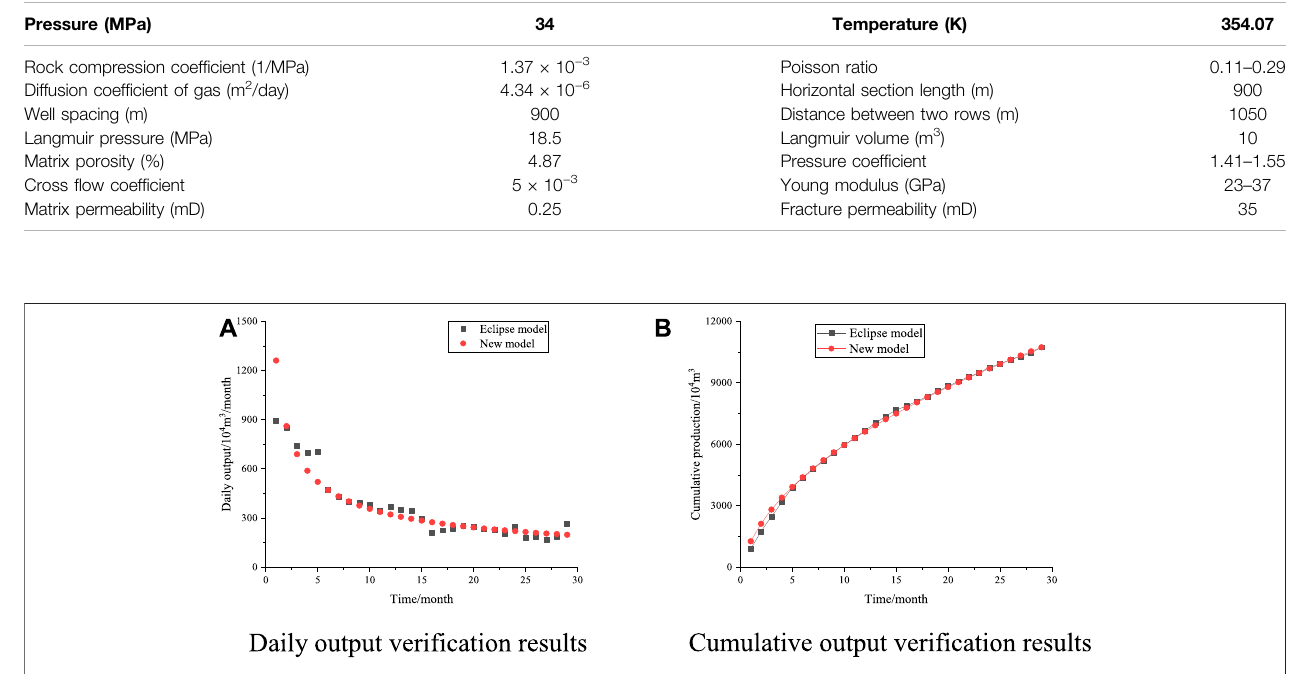
TABLE 3 | Model parameters.